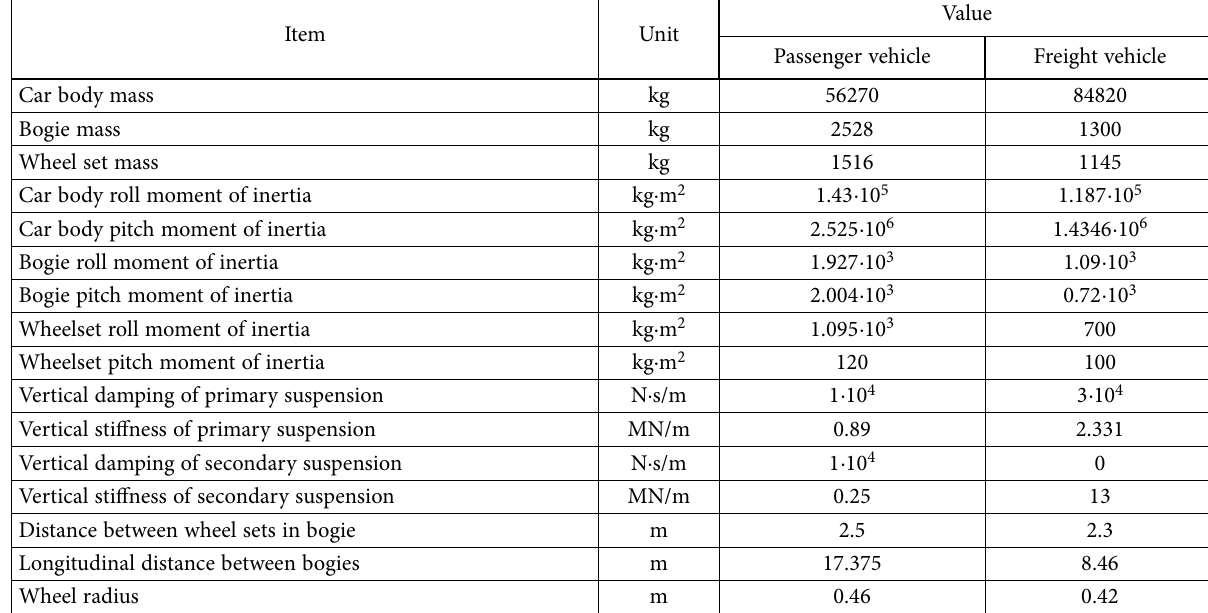
Table 1. Main parameters of high-speed passenger and heavy axle-load freight vehicles